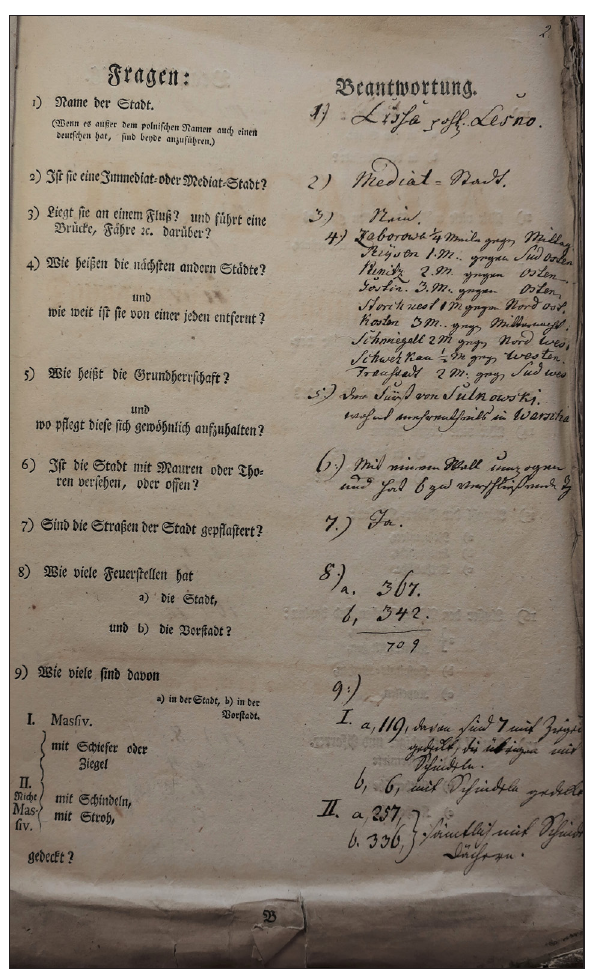
Figure 3: First page of Lissa’s Indaganda survey. 1793. Source: GStA PK II. HA GD, Abt. 10 Südpreußen, Tit. VI, Nr. 1536. Zustand der Stadt Lissa. Topographisch- Statistischer Fragebogen